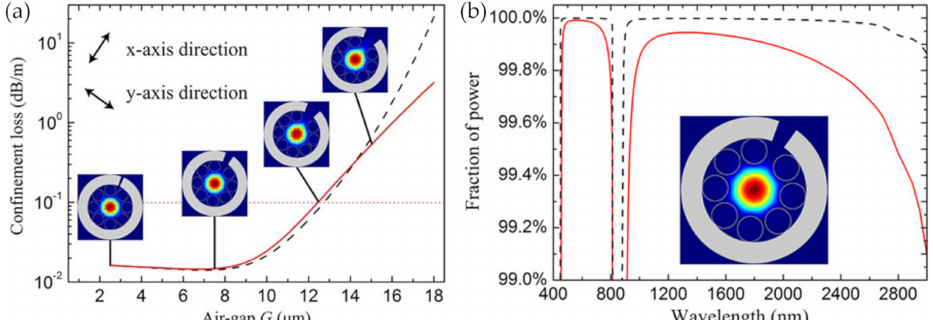
Figure 14. ( a ) Confinement losses in two orthogonal polarization directions (the x -axis is the black dashed line and the y -axis is the red solid line) as functions of the larger gap G for the PCF at the wavelength of 1550 nm. The inset are the fundamental mode patterns in the y -axis direction with G values of 2.5, 7.5, 12.5, and 15 µ m at the wavelength of 1550 nm, respectively. ( b ) A fraction of power inside the air core (red solid line) and in air (black dashed line) of the fiber with a G value of 7.5 µ m. The inset is the mode pattern of the fundamental mode at the wavelength of 1550 nm